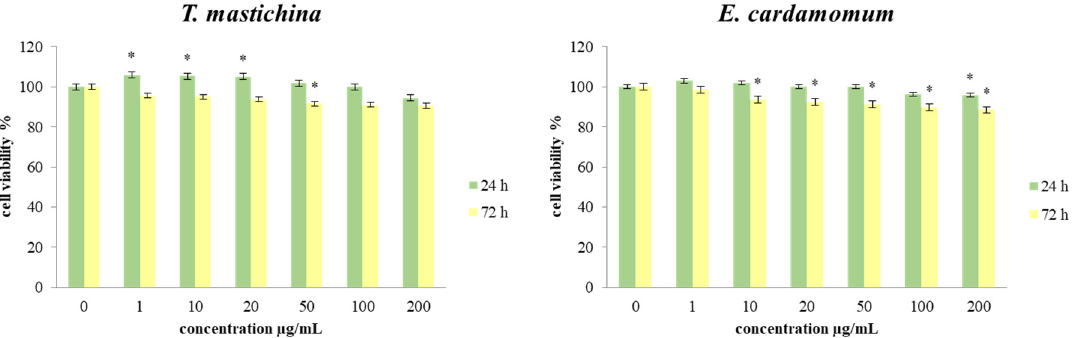
Figure 1. The effects of control treatment and six concentrations of EOs on MDA-MB-468 cell viability after 24 and 72 h of treatment. Results are presented as the mean of three independent experiments ± standard error: * p < 0.05 relative to control.